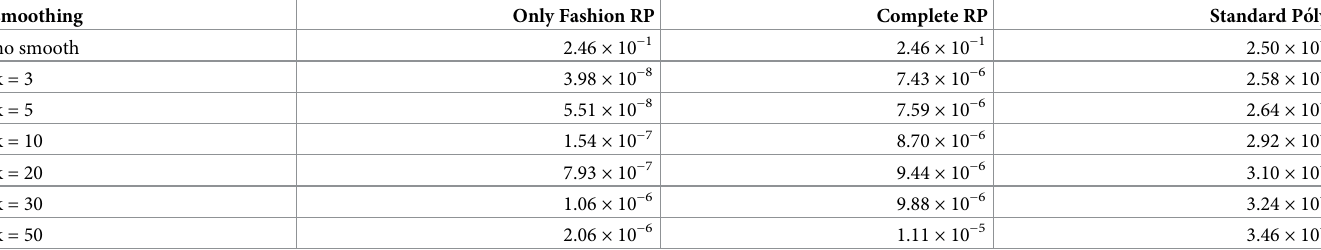
Table 24. “Covid” ( T = 0.35, entire, D = 3 0 , slots = days): MSE for different levels of smoothing. smoothing